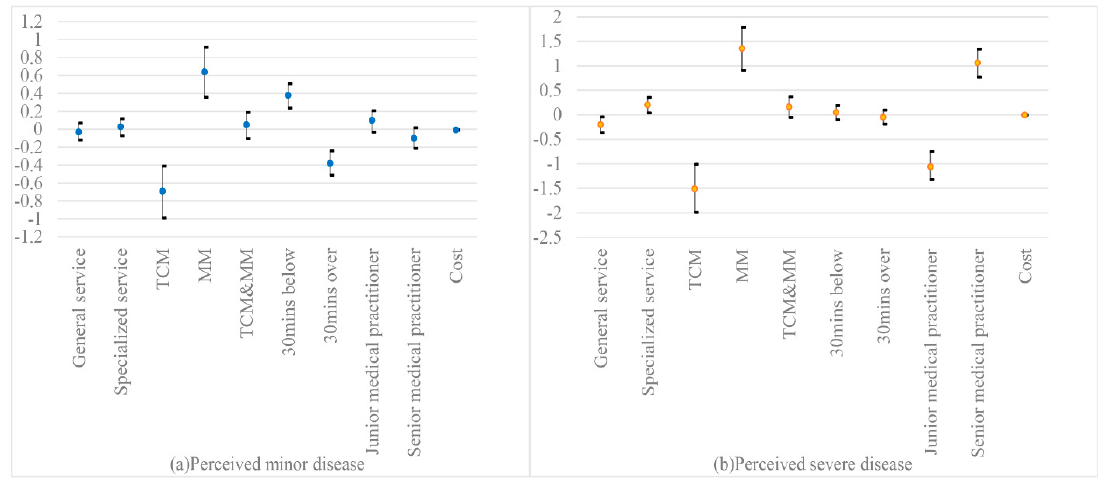
Figure 2. Preference weights with a 95% CI.